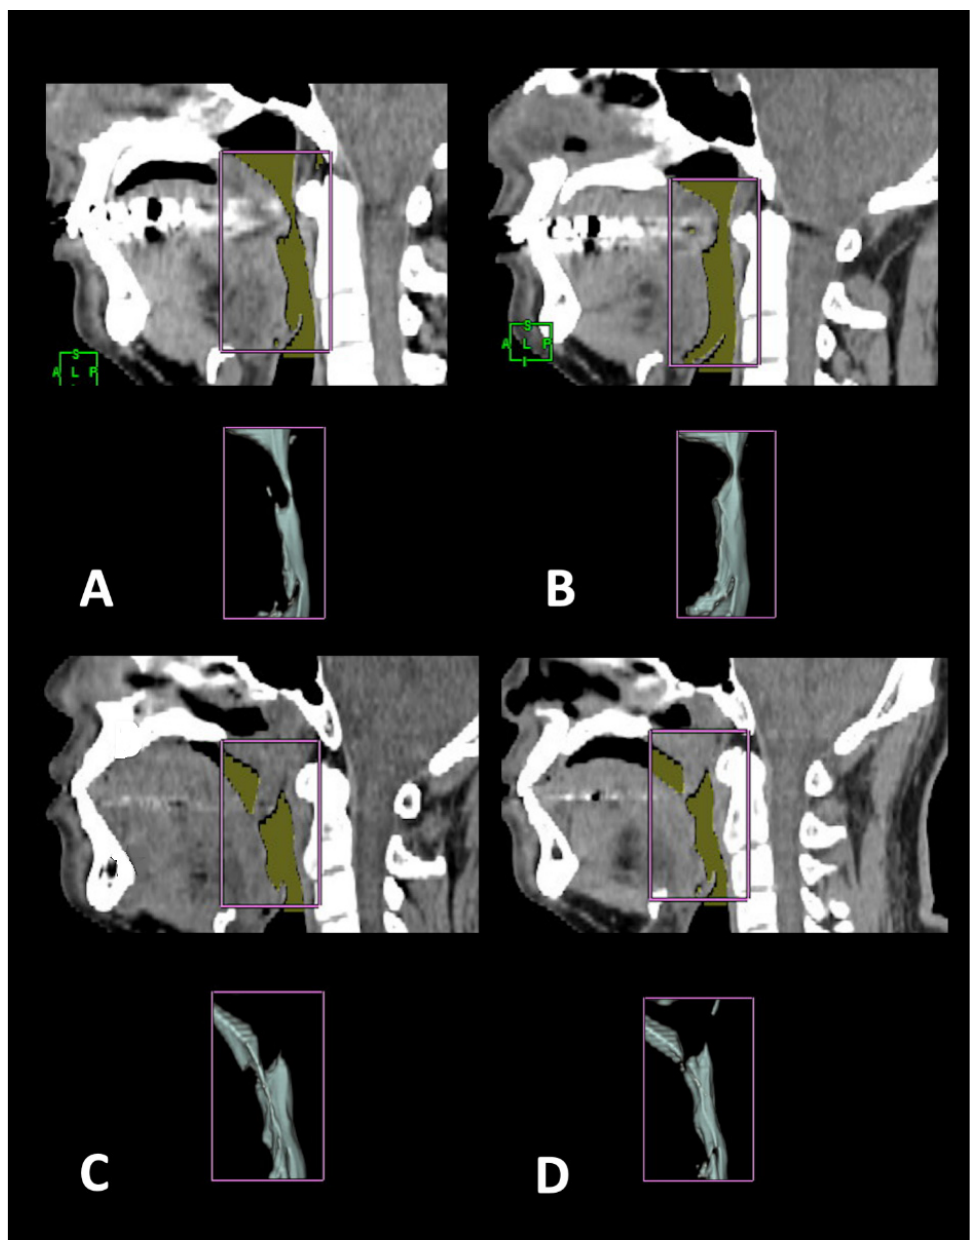
Figure 2. Total airway volume in one surgical success patient: ( A ) pre-surgery, ( B ) post-surgery. Total airway volume in one surgical failure patient: ( C ) pre-surgery, ( D ) post-surgery.